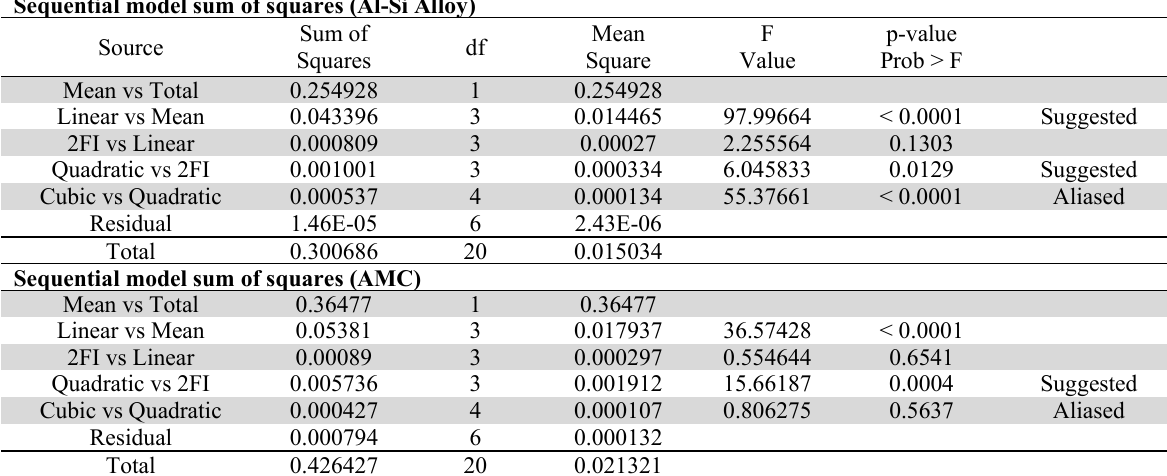
Sequential model sum of squares (Al-Si